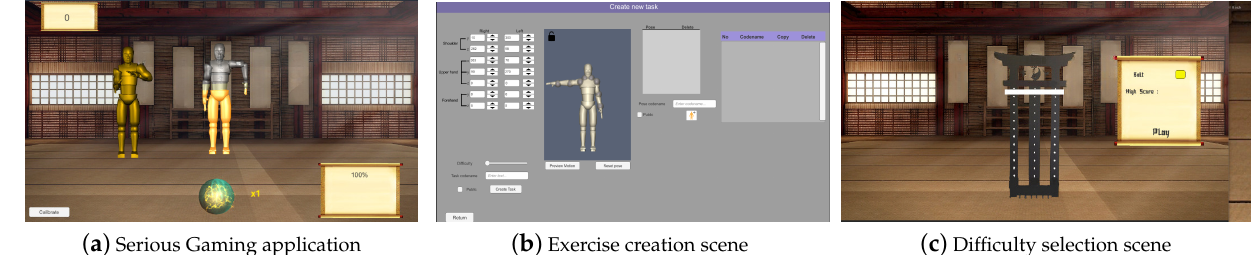
Figure 3. Serious gaming application for the NeuroSuitUp neurorehabilitation